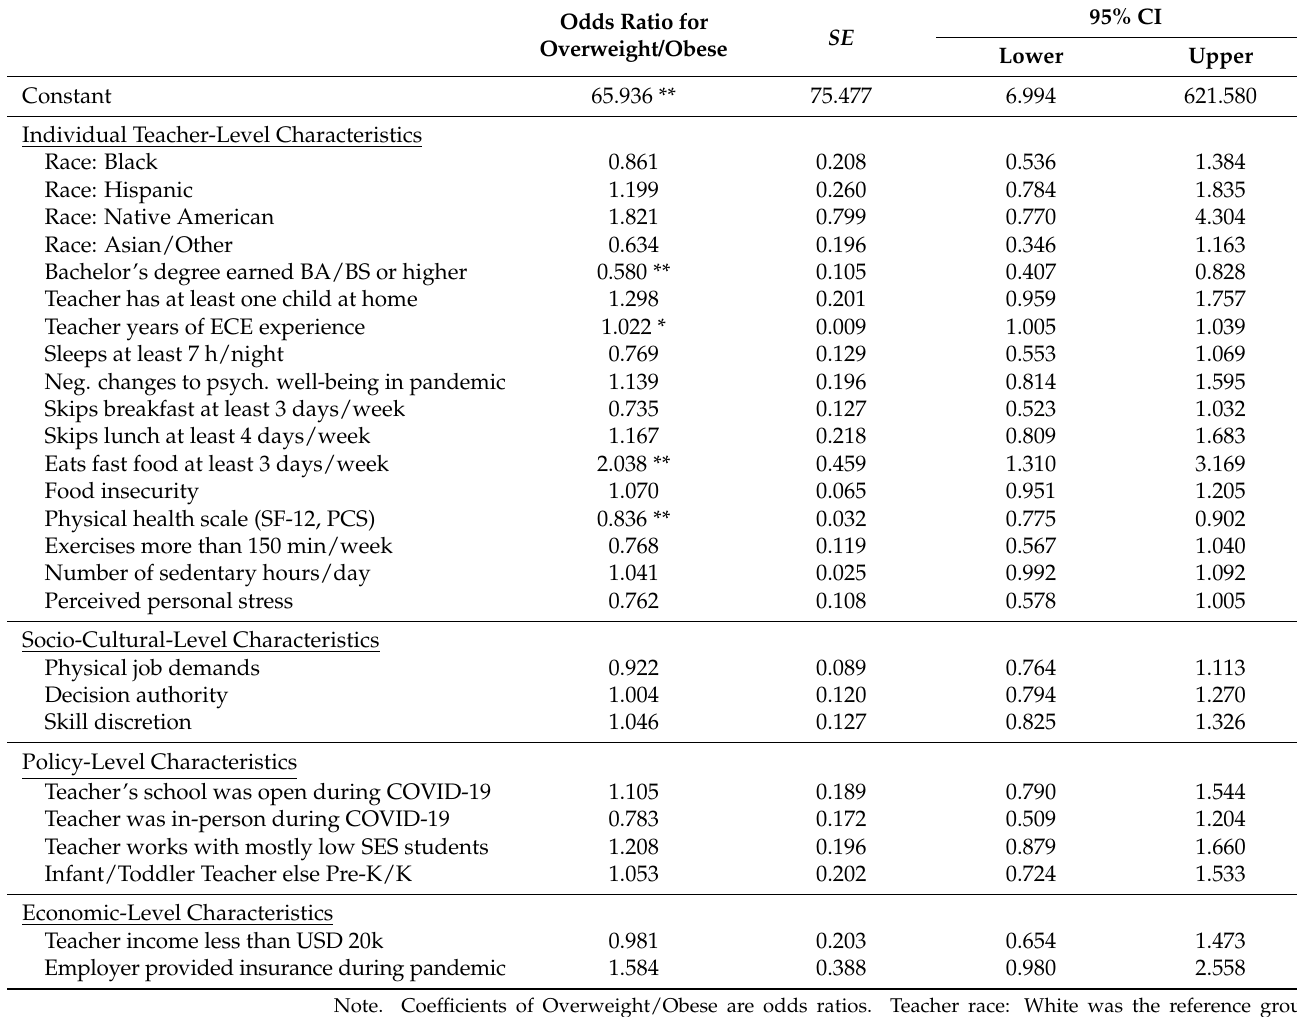
Table 3. Logistic Regression Predicting Overweight/Obese Weight Status for Early Care and Educa-